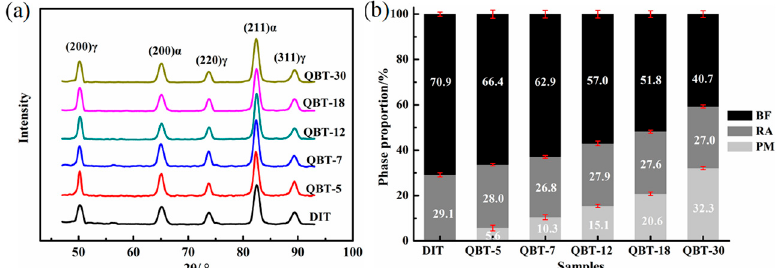
Figure 6. XRD patterns ( a ) and phase proportion ( b ) of different samples after isothermal treatment at 300 °C for 4 h.